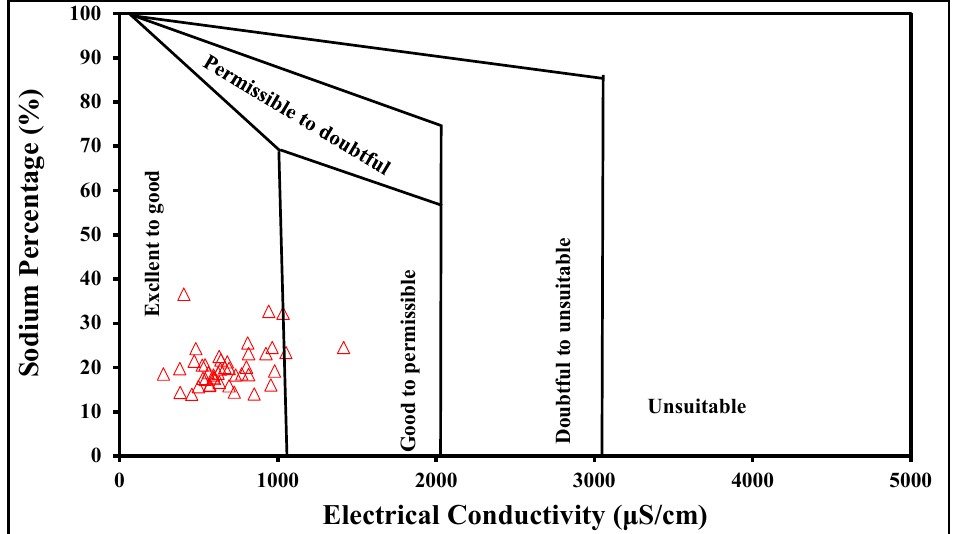
Figure 10. Plot of sodium percent (Na%) vs. electrical conductivity (EC). The total soluble salts in irrigation water determines salinity zone as low (EC = <250 µS/cm), medium (EC 250–750 µS/cm), high (EC 750–2250 µS/cm) and very high (EC 2250–5000 µS/cm). High value of EC in water leads to salinity and high sodium concentration leads to alkalinity in soil. It is reported that generally high concentration of solutes is present in irrigation water in areas where evaporation is maximum [42]. Normally, salinity problem arises where drainage is poor in irrigated agriculture. Due to the poor drainage, water table rises and due to capillary action, sodium salts accumulate in the soil near the root zone of the plants. In the present study, no samples fell in the low salinity category; however, 69% and 31% samples fell in medium and high salinity category which may be due to shallow water table in the area. Conjunctive use of water by mixing ground water with normal surface water in proper proportion should be practiced to avoid soil salinity. The US salinity diagram, showing SAR and EC that represents alkalinity hazard and salinity hazard, respectively, reflects that no sample fell in the category C1S1, while most of the water sample were in C2S1 (68.8%), C3S1 (31.11%) category indicating medium to high salinity (Figure 11) but suitable for irrigation use.